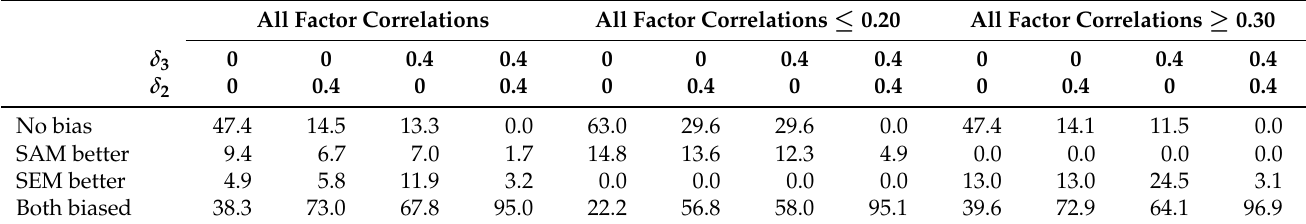
Table 10. Simulation Study 5 (three factors and cross loadings): percentages of factor